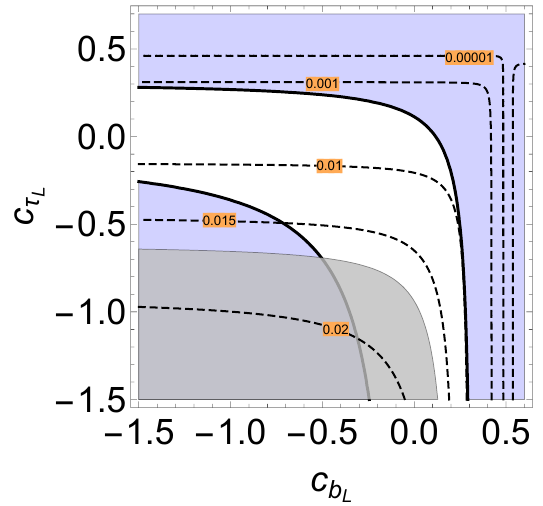
Figure 17 . Contour plot of (cid:27) as a gray band in the bottom part of the (cid:12)gure the experimentally excluded region (cid:27) We overlap as well the allowed region coming from the ( R D ; R D (cid:3) ) observables. We have considered c (cid:22) = 0 : L